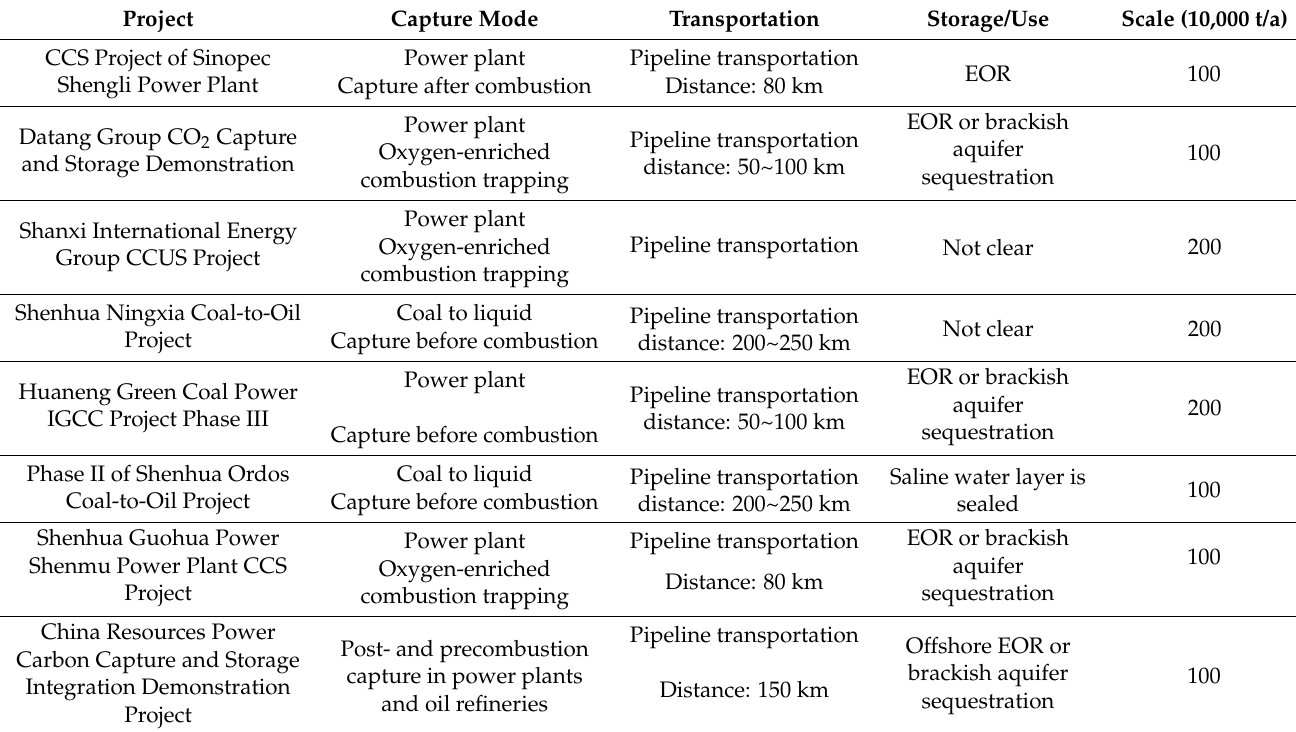
Table 1. Some of the large-scale CCUS integration demonstration projects in